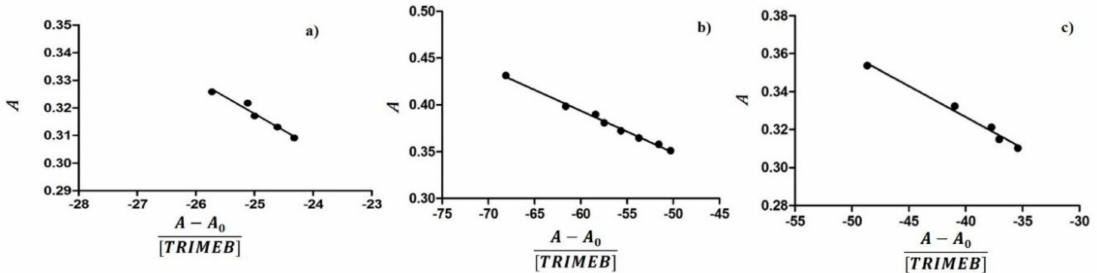
Figure 5. The dependence of the HPPA absorbance from the TRIMEB concentration in aqueous solutions at different pH values: ( a ) pH = 4.3 ( λ = 323.5); ( b ) pH = 5.3 ( λ = 326.0); and ( c ) pH = 8.3 ( λ = 332.0).